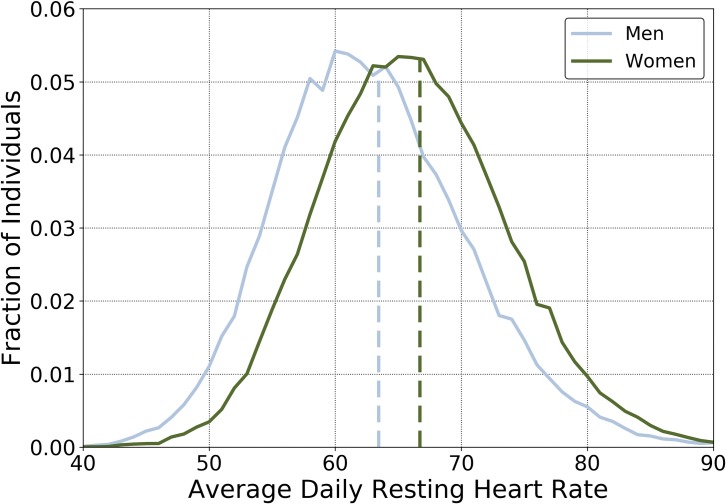
Distribution of average daily resting heart rates.The average daily RHR for 57,836 individual women (green line) and 34,621 men (blue line). The overall mean for each group is indicated by the dashed lines.